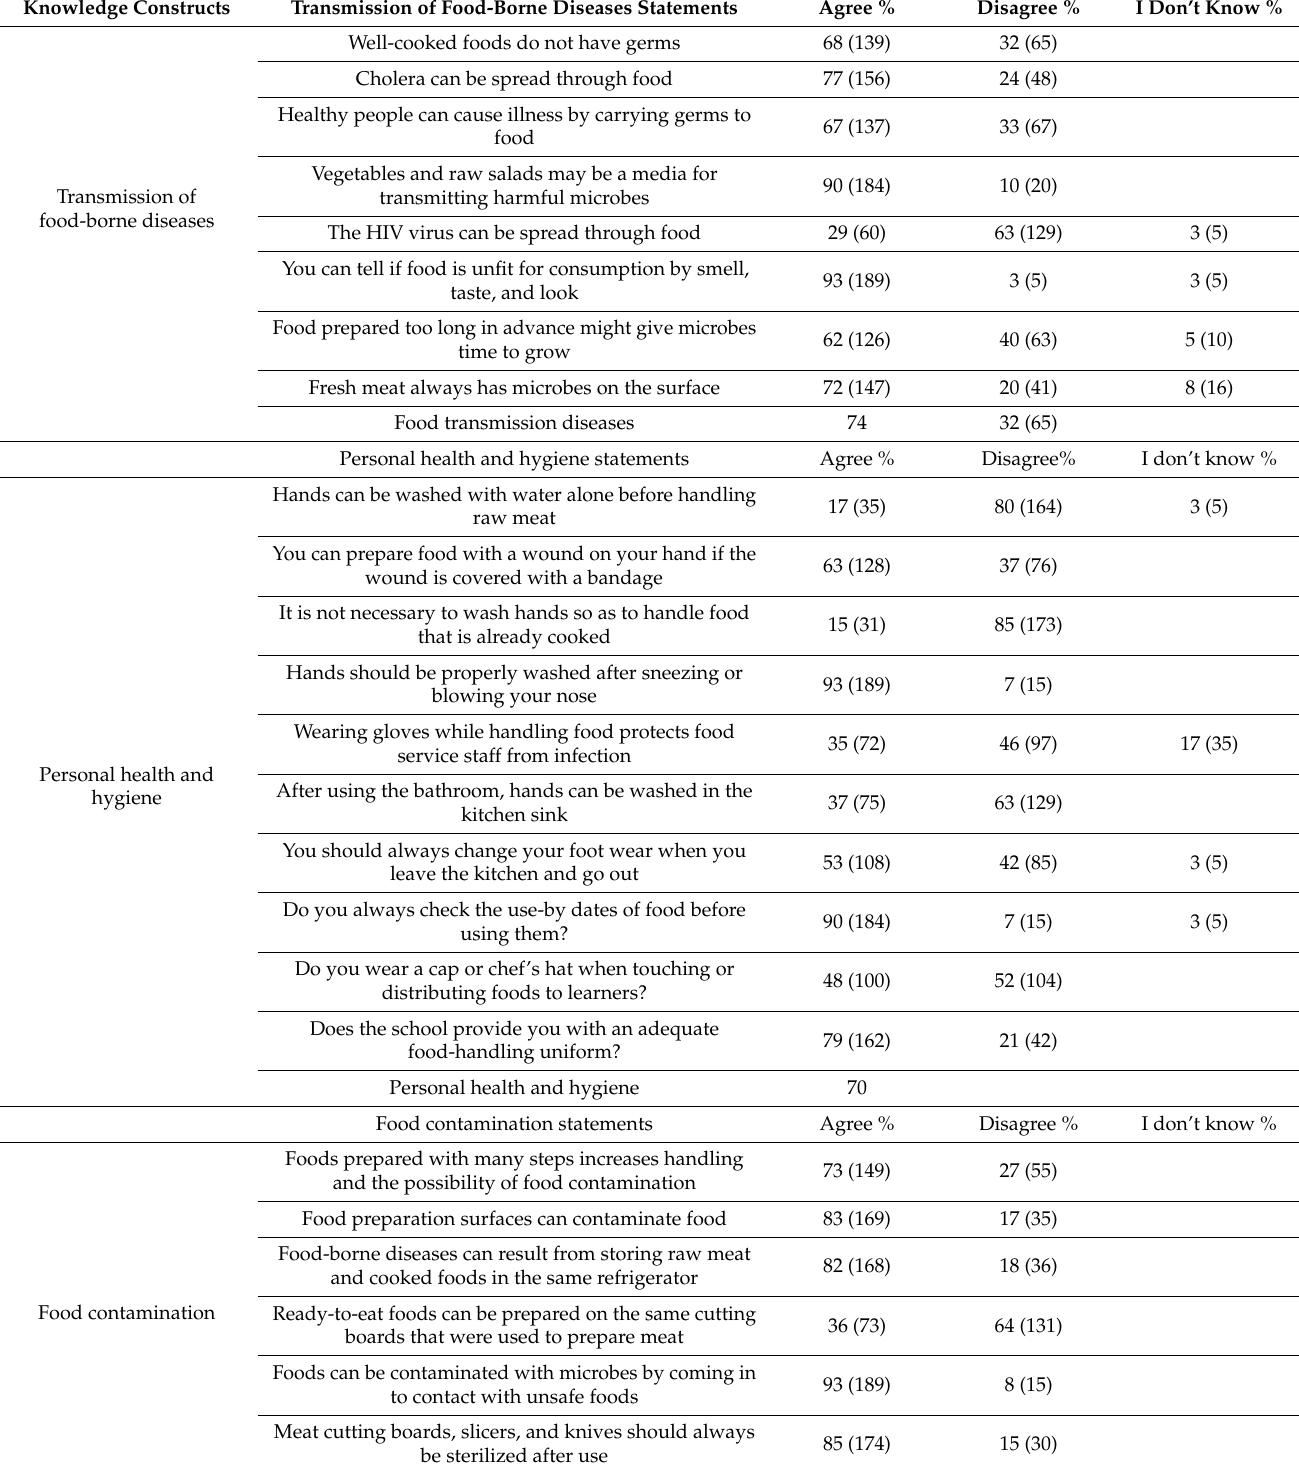
Table 5. The frequency of knowledge scores for food-borne diseases transmission, personal hygiene, and food contamination of food handlers in Kenyan high school kitchens (% and the number of respondents in